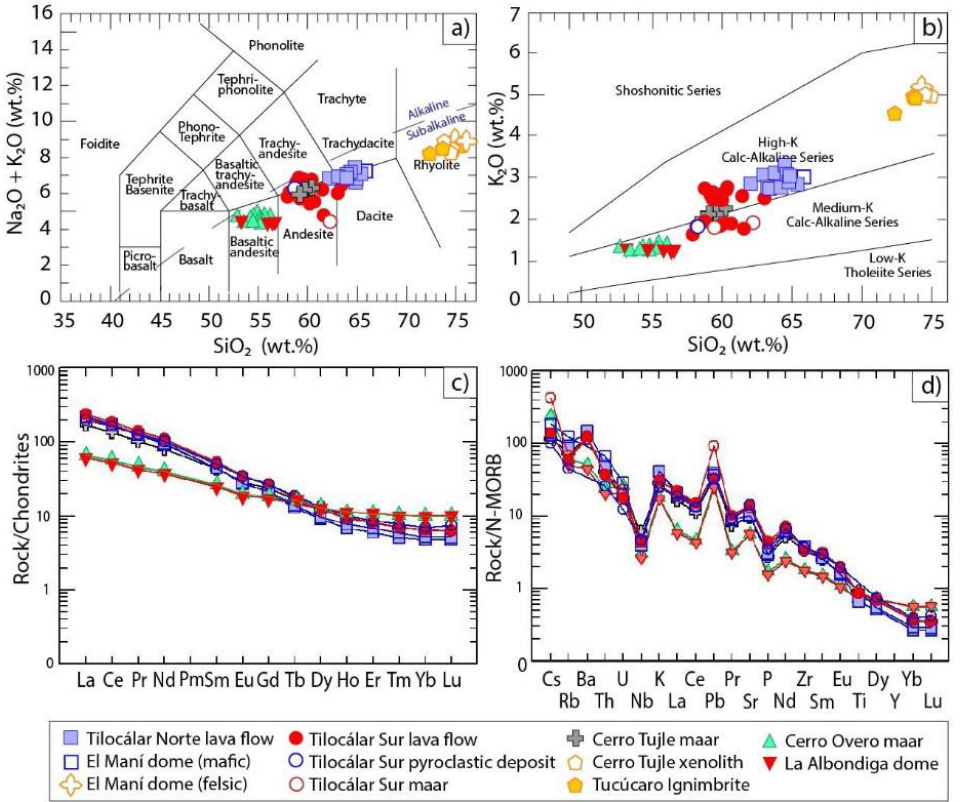
Figure 8. ( a ) TAS diagram (after [126]). ( b ) Alkali silica diagram [127]. ( c , d ) Multi-element diagrams, Chondrite and N-MORB, respectively (normalized values from [128]). Data taken from Ureta, et al. [53], Ureta, et al. [50], and Ureta, et al. [54]. Overall, all the samples display mixing processes that are evidenced in the absence of linear